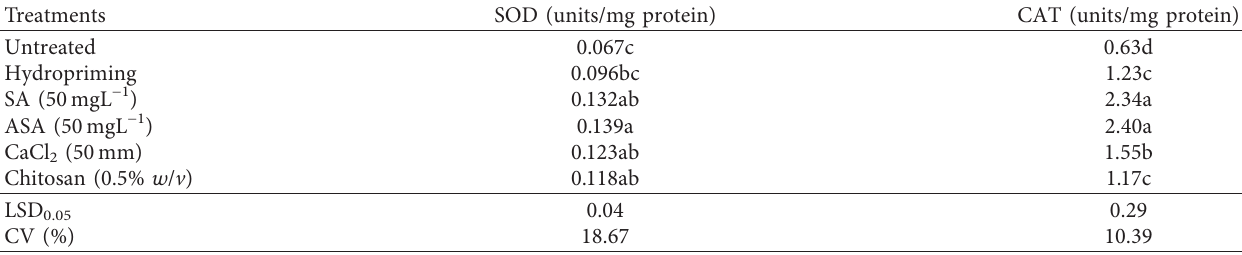
Table 4: Effects of seed priming on superoxide dismutase (SOD) and catalase (CAT) activities before 9months of